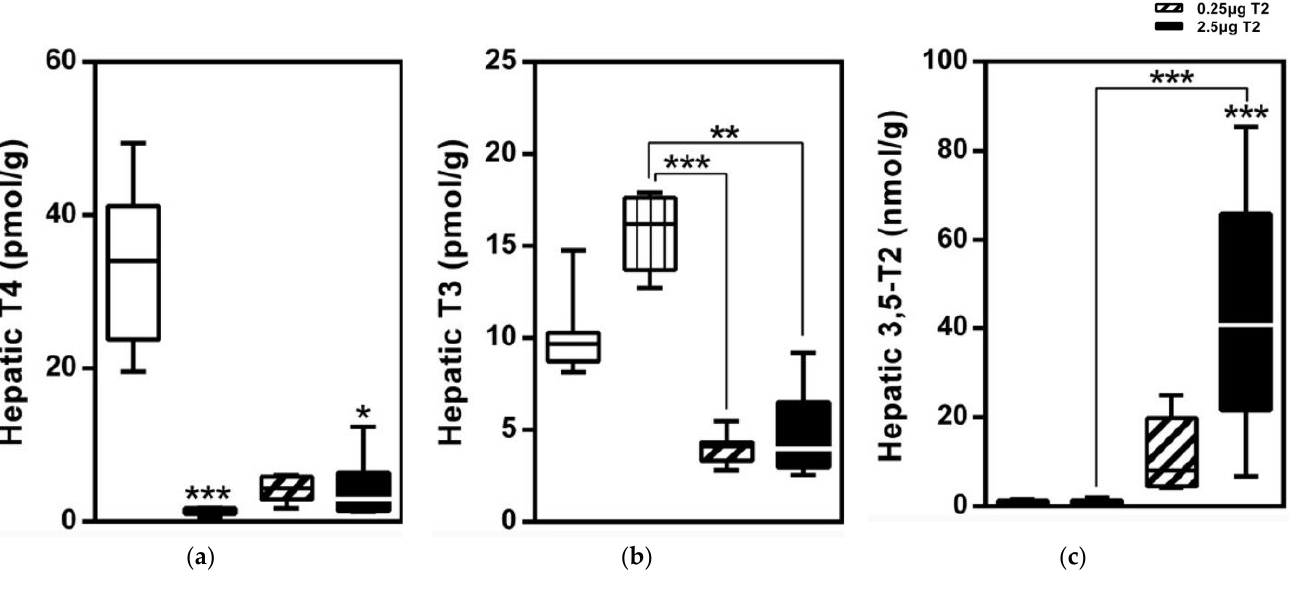
Figure 4. Hepatic TH profiles after a 14-day treatment with 3,5-T2 as measured by LC-MS/MS: He- patic TH concentrations of HFD mice injected (i.p.) with either T3 (0.03 µg/g body weight) or 3,5-T2 (0.25 or 2.5 µg/g body weight) once daily at onset of dark cycle for 14 days to validate effects of 3,5-T2 in comparison with T3 ( n = 7 – 8). ( a ) serum T4, ( b ) serum T3, and ( c ) serum 3,5-T2 *, p < 0.05; **, p < 0.01; ***, p < 0.001 vs. control or as indicated ( n = 6 – 8). Reprinted with permission from Ref. [1] , © 2015, Endocrinology.